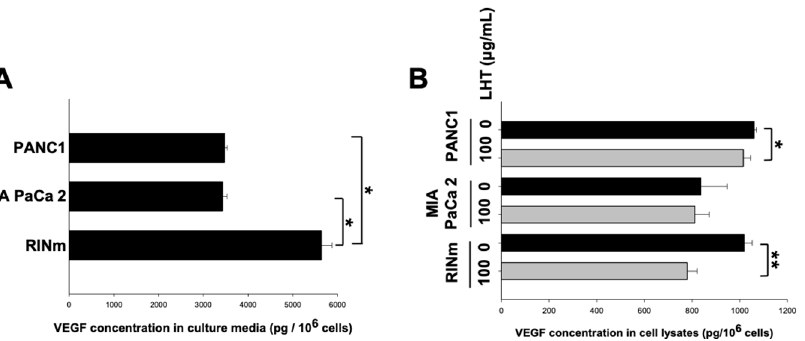
Figure 2. Reduction in VEGF secretion in pancreatic cancer cells after treatment of LHT. ( A ) Quantitative analysis of VEGF secretion from all types of pancreatic cancer cells without treatment of LHT. Data were expressed with mean ± s.e.m. (n = 5). * p < 0.05 versus the RINm cell line. ( B ) Relative quantification of VEGF in the cell lysate of pancreatic cancer cells after cultivation without (black bar) or with (grey bar) treatment of LHT (100 µg/mL) for 24 h. Data were expressed with mean ± s.e.m. (n = 5). * p < 0.05 and ** p < 0.01 versus each group without LHT.